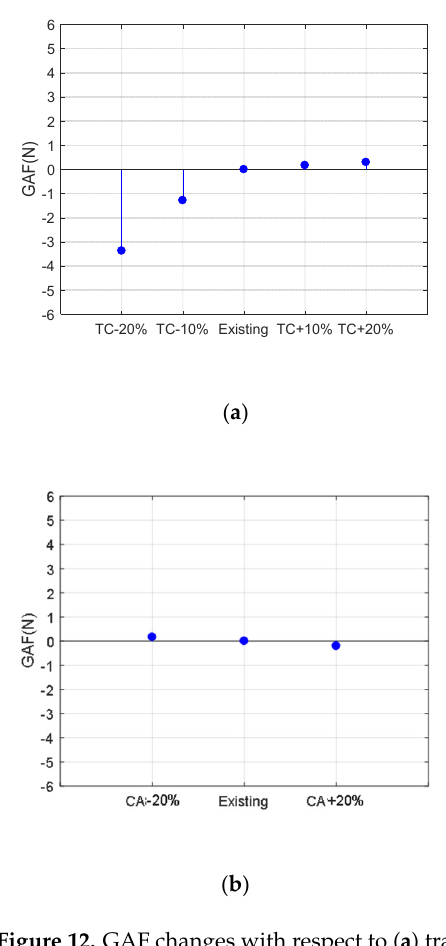
Figure 12. GAF changes with respect to ( a ) track curvature ( b ) contact angle.